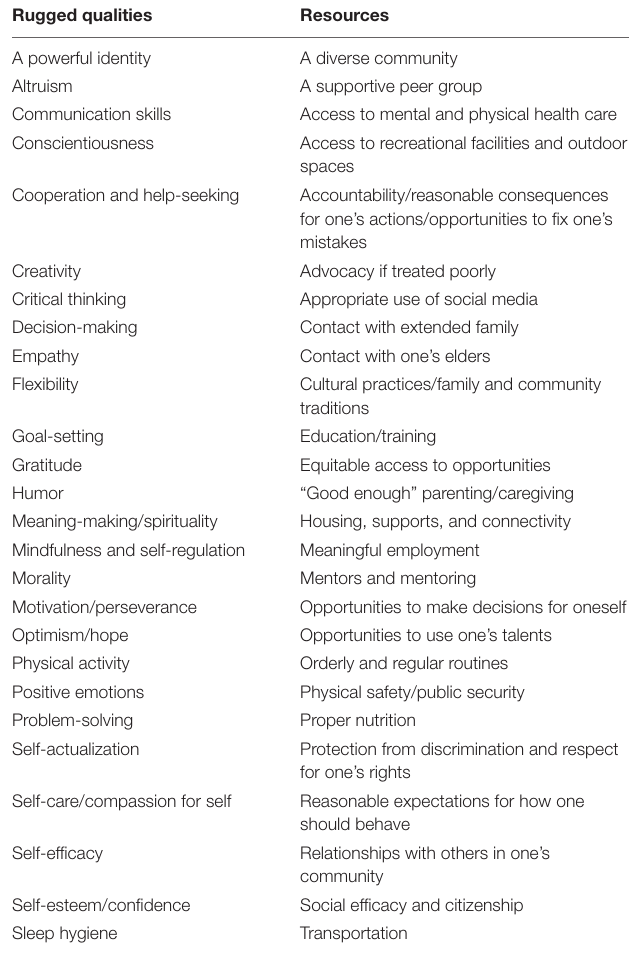
TABLE 1 | The R2 Resilience Program’s© 52 resilience